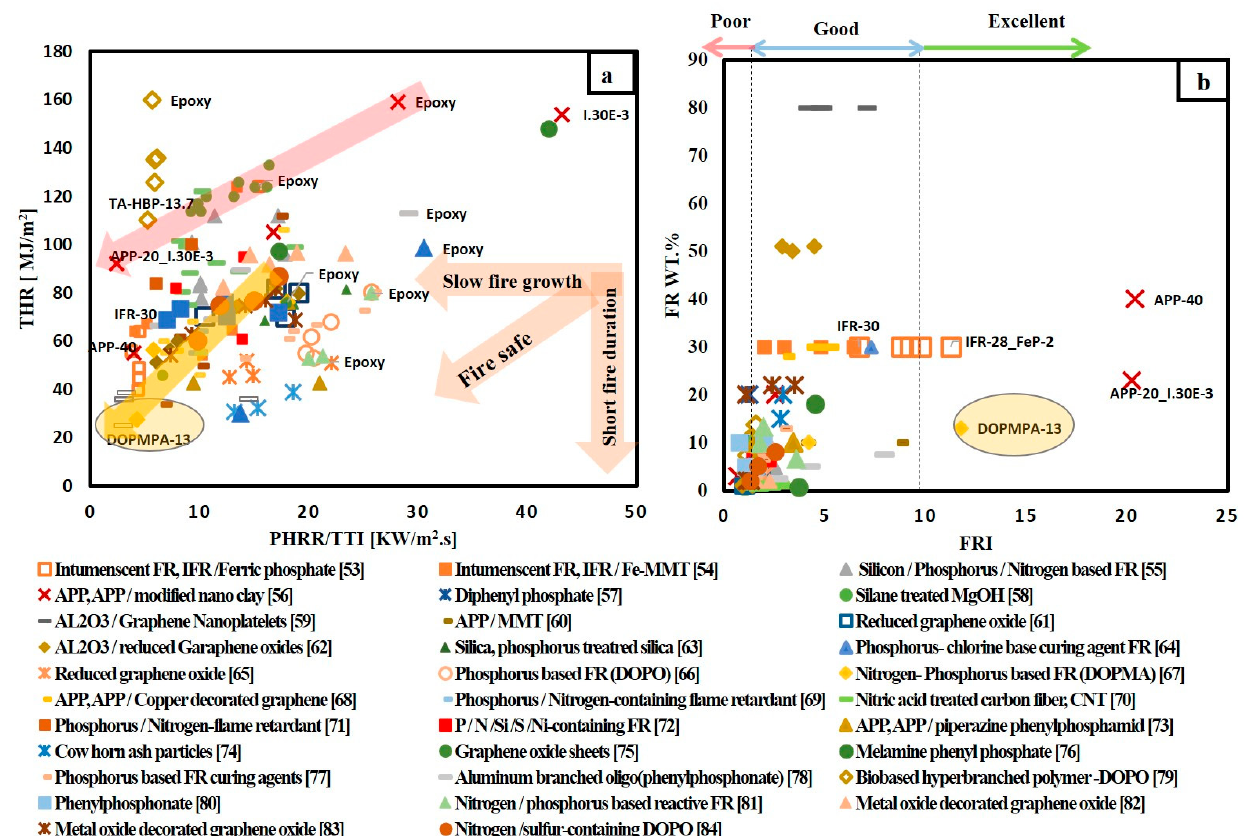
Figure 3. ( a ) THR versus PHRR/TTI for different FR/epoxy resin systems; ( b ) FR wt.% versus flame retardancy index (FRI) for different FR/epoxy resin systems.